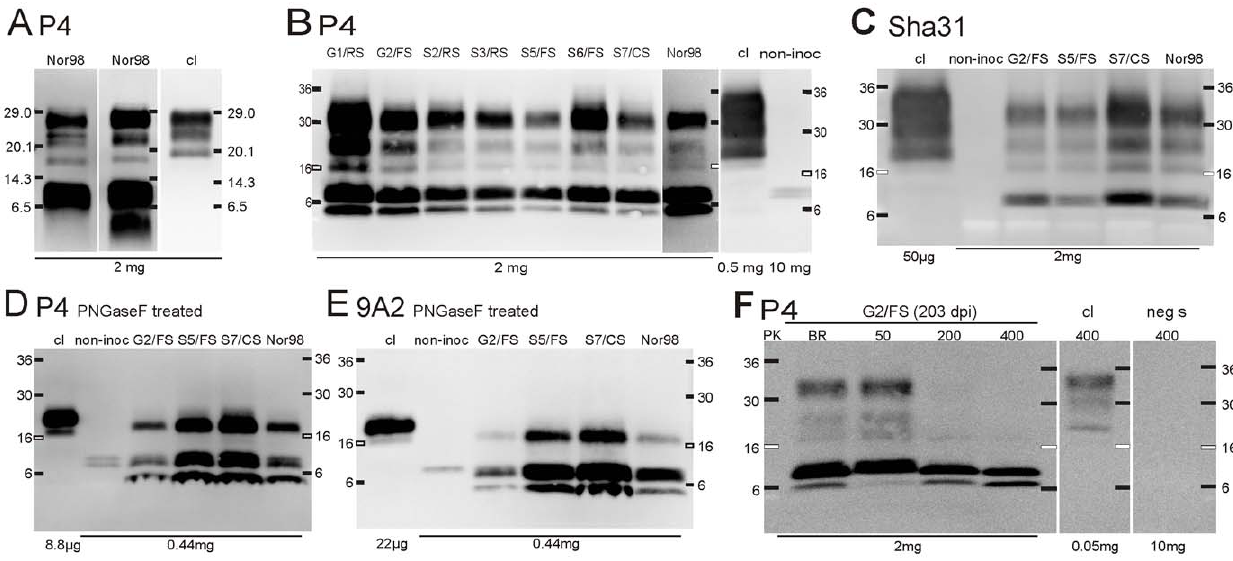
Figure 6. Molecular PrP res typing of atypical scrapie affected tg338 mice. Western blots for PrP res of representative brain extracts following SDS-PAGE using (A) 16.5% tris-glycine and (B-F) 4–20% tris-glycine gradient gels. Immunochemical detection was performed with antibodies P4, Sha31 or 9A2 as indicated. In some instances ( D , E) , samples were deglycosylated with PNGaseF. (F) Atypical scrapie PrP res banding pattern following sample pretreatment with different concentrations of proteinase K (PK, in m g/ml), compared to the PK digestion protocol of the Bio-Rad TeSeE confirmatory Western blot (BR). Identification codes for the atypical scrapie isolates are shown at the top. Controls: cl, classical scrapie affected tg338 mouse; non-inoc, non-inoculated tg 338 mouse; neg s, TSE negative sheep. Molecular mass standards in kDa and loaded tissue equivalents are indicated.